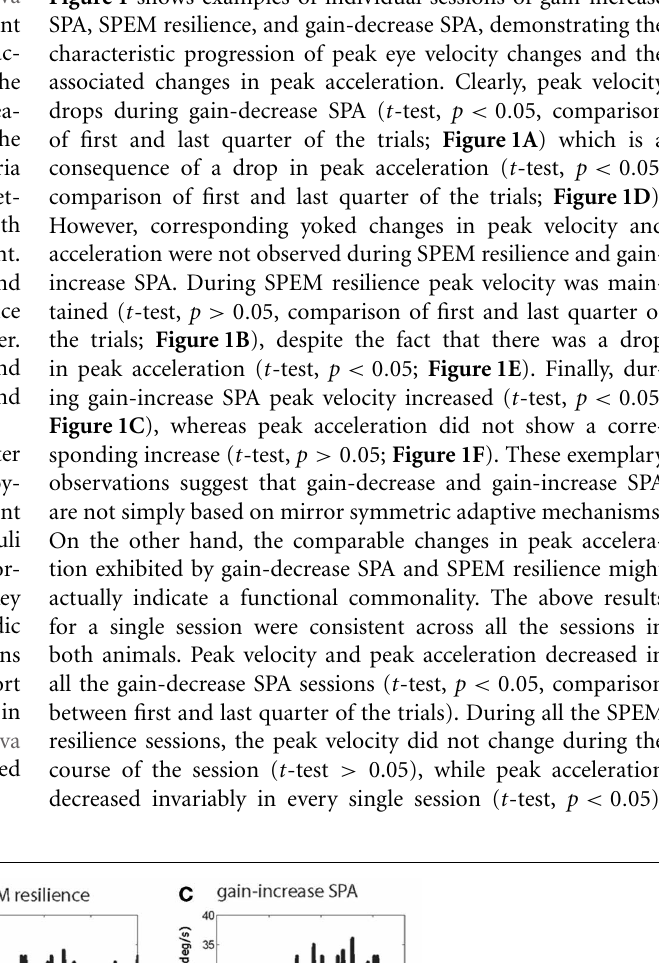
course of sessions, the middle row depicts the accompanying changes in peak acceleration (D–F) . The lower row (G–I) shows the correlation between peak velocity and peak acceleration on a trial to trial